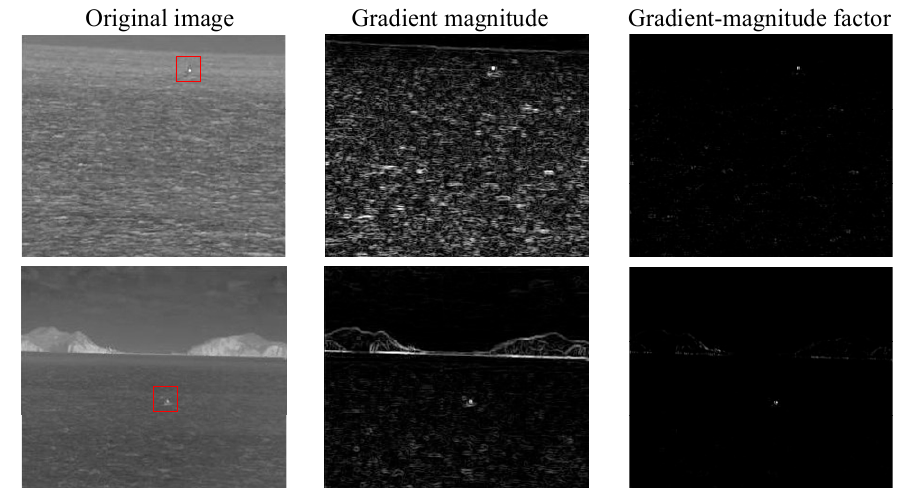
Figure 11. Result of using G L and G V to analyze gradient in